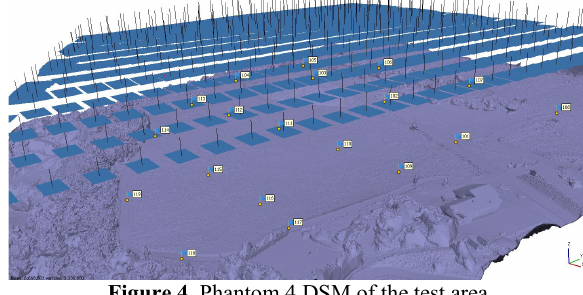
Figure 4 . Phantom 4 DSM of the test